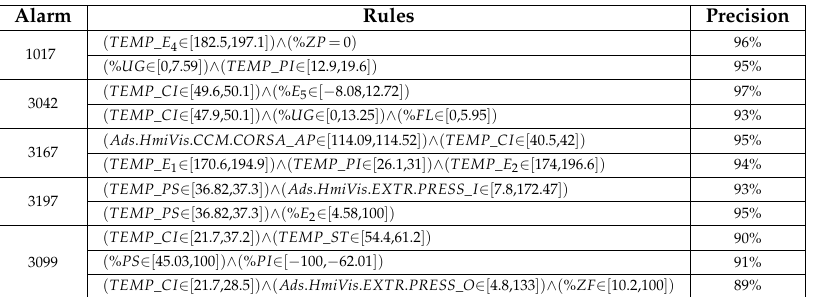
Table 4. Relaxed Separate-and-Conquer (RSC) (RUL = 60 s).